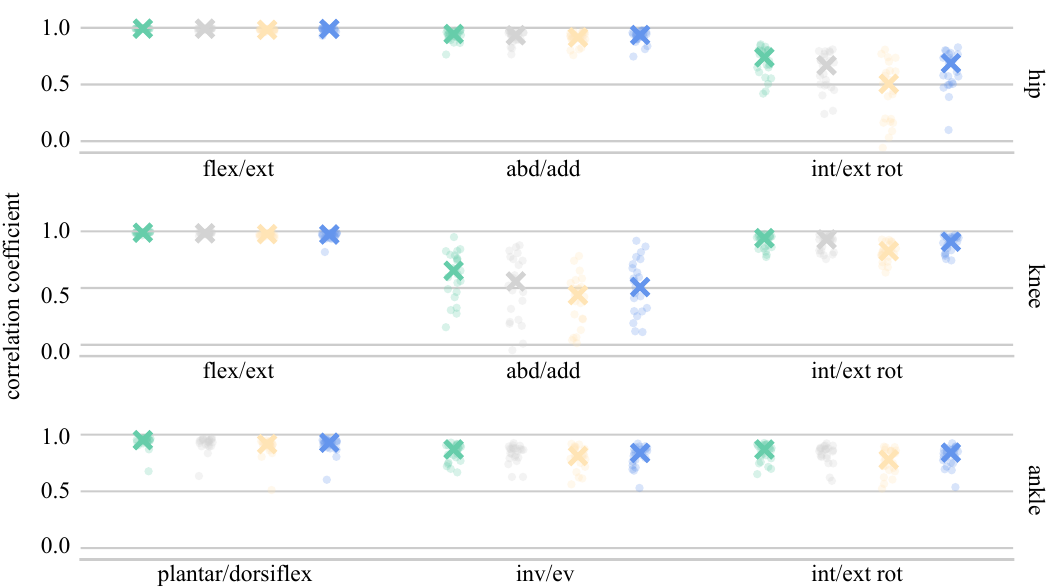
Figure 8. Median and single LOSO validation correlation coefficients for the prediction of joint